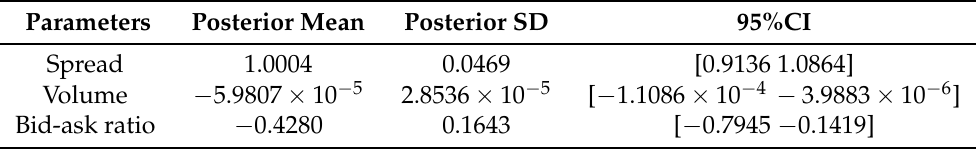
Table 28. Estimated parameters about limit order book (27 July 2016, JAL, Tokyo, Japan).